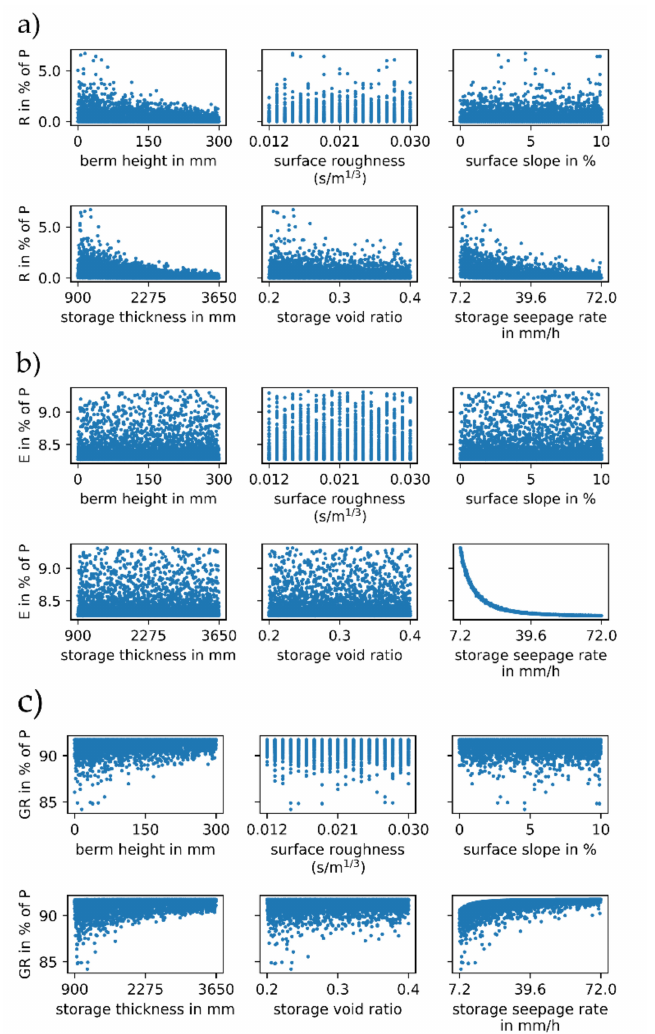
Figure 4. Results of the long-term simulations for the infiltration trench depending on the value of the six infiltration trench parameters. Each dot illustrates the result of a parameter sample. ( a ) Runoff volume (R); ( b ) evaporation (E); ( c ) groundwater recharge